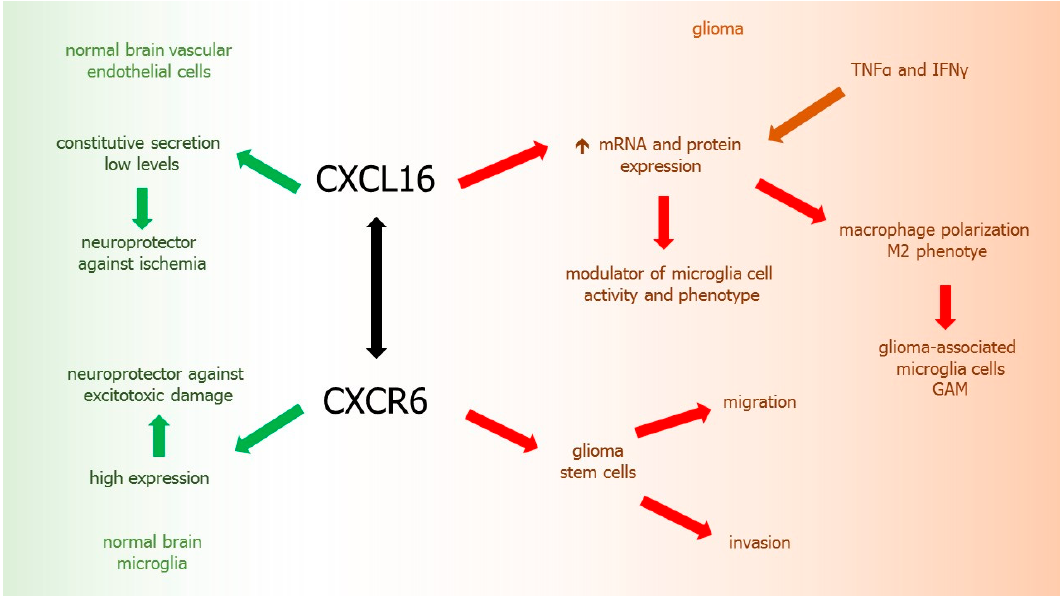
Figure 4. CXCL16-CXCR6 axis in glioma development. Green arrows: chemokine activity in normal brain tissues, red arrows: chemokine activity in glioma, brown arrows: factors inducing chemokine, black arrow: chemokine-receptor axis.